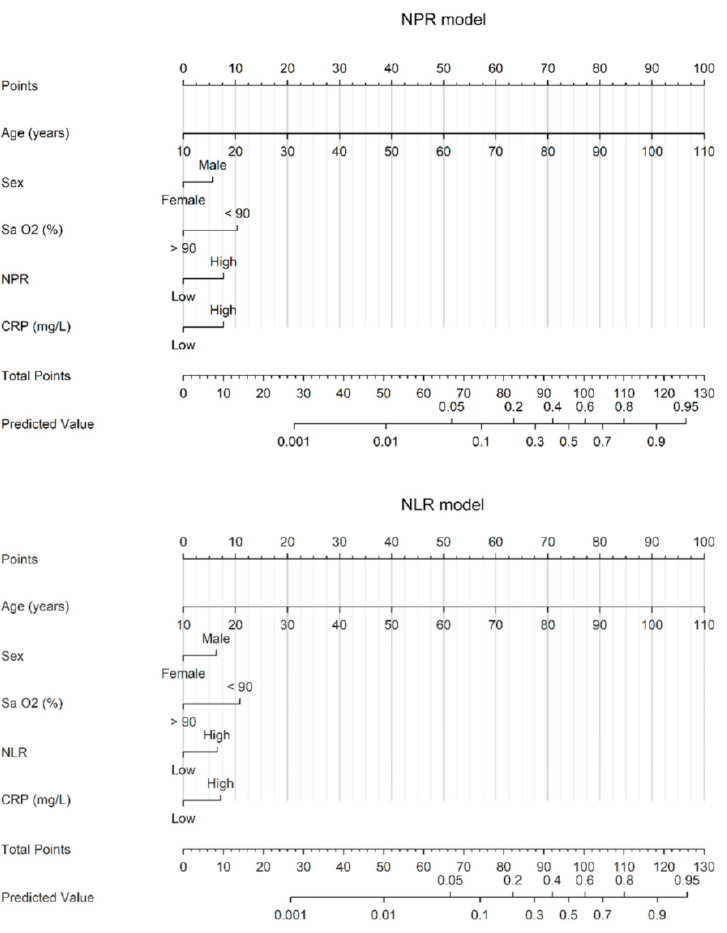
Figure 1. Nomograms of the NPR and NLR models. Abbreviations: SaO 2 , oxygen saturation; NLR (high: >6.9), neutrophil-lymphocyte ratio; NPR (high: >3.0), neutrophil-platelets ratio; CRP (high: >112 mg/L), C-reactive